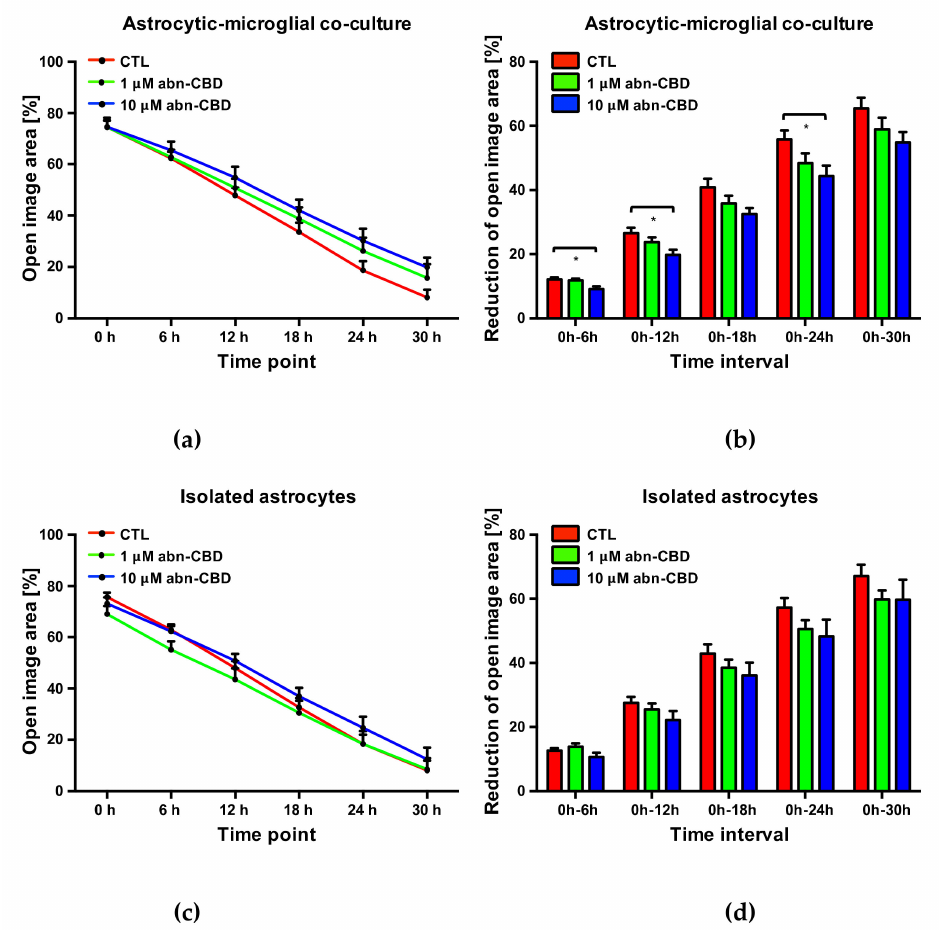
Figure 5. Open image area ( a , c ) and cumulative reduction of open image area ( b , d ) in astrocytic-microglial cocultures ( a , b ) and isolated astrocytes ( c , d ). Data is expressed as mean ± SEM, n = 8 in each group. Statistical analysis was done using one-way ANOVA followed by Bonferroni’s post-test. * p <